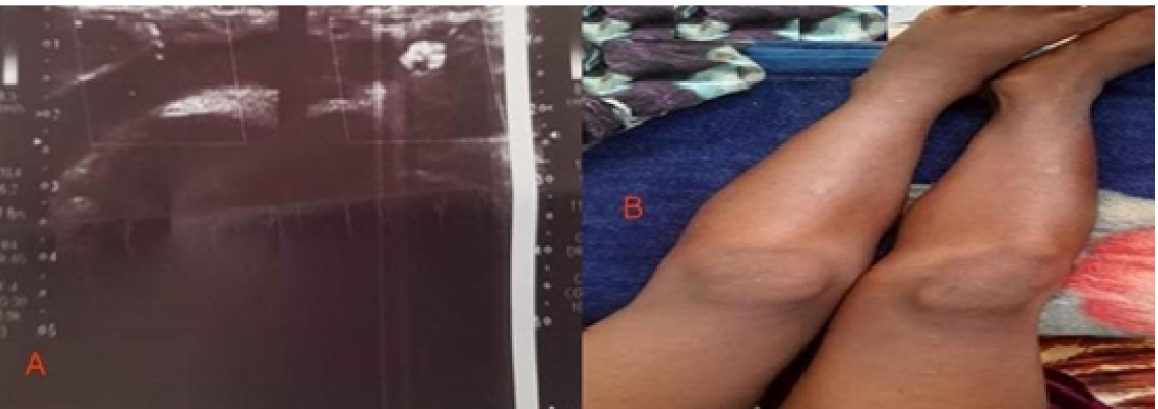
Figure 2. ( A )Patientoninitialpresentation, Dopplerultrasound, and( B